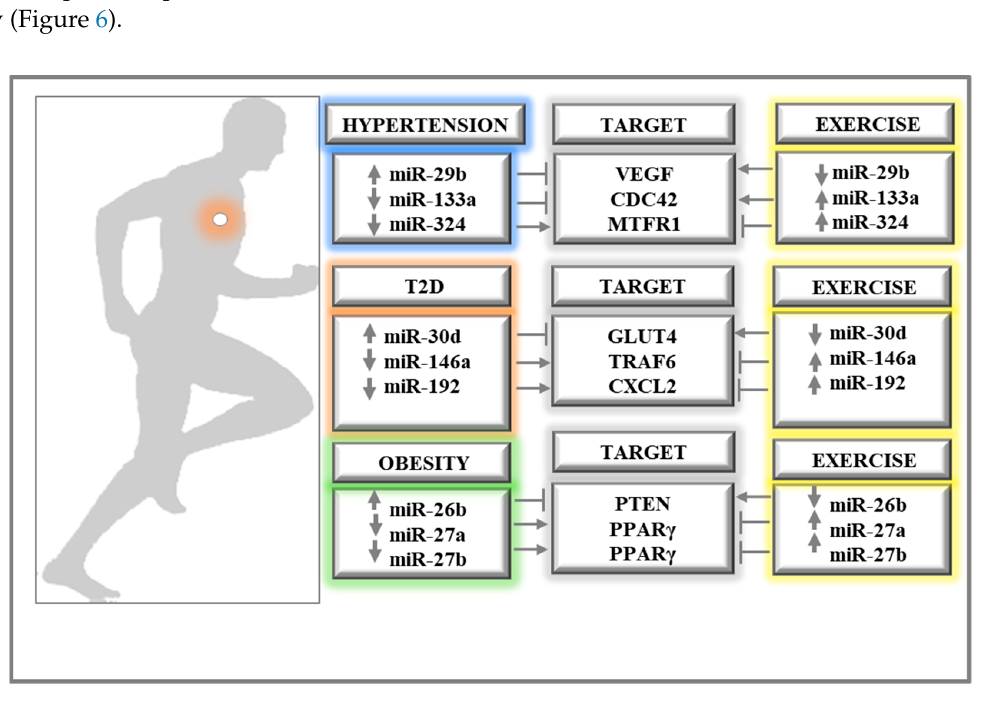
Figure 6. The opposite regulation of miRNA expression after exercises and their targets. The scheme illustrates examples of miRNAs with differential expression reported for diseases and exercise training. The respective gene target is also indicated. ↑ = upregulated, ↓ =